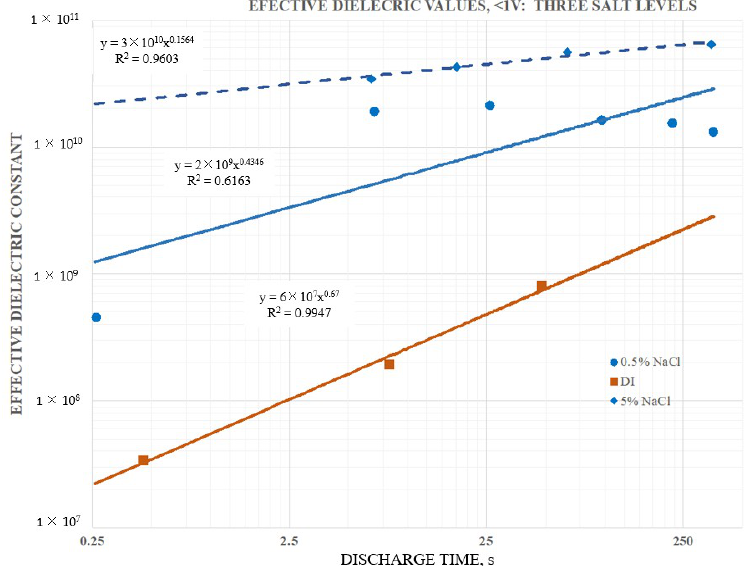
Figure 4. Effective dielectric constant as a function of the salt concentration. The three curves, based on capacitance below 1 V, were obtained with the 20 mm capacitor and were all for a super dielectric outside/ambient air dielectric inside configuration, all based on a program of charging to ±10 V and holding for 200 s at ±10 V. As the salt concentration increases, the effective dielectric constant does. It was also clear that the effective dielectric constant for both the 0.5 and 5 wt % NaCl samples was nearly independent of discharge time for discharge times longer than ~5 s. In particular, the 0.5 wt % NaCl data could not be fitted with a power law.